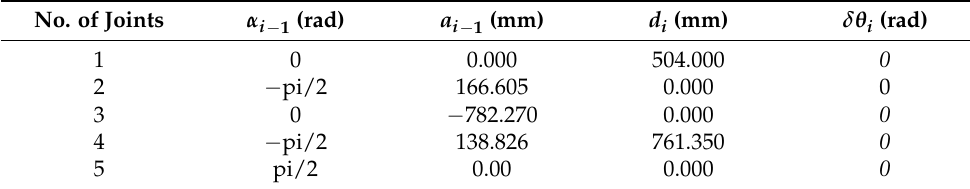
Table 5. The kinematic parameters of the ER20-C10 robot after calibration.